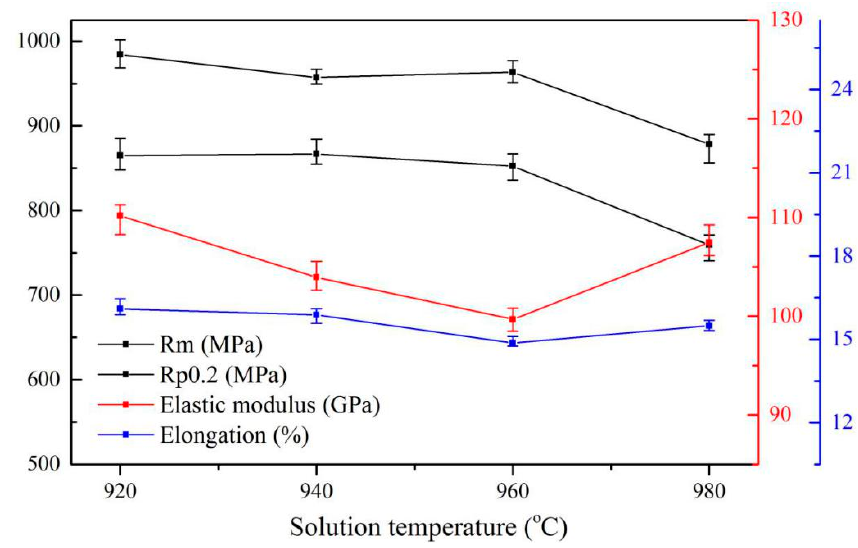
Figure 5. Mechanical properties of microstructures obtained by different solution treatments.